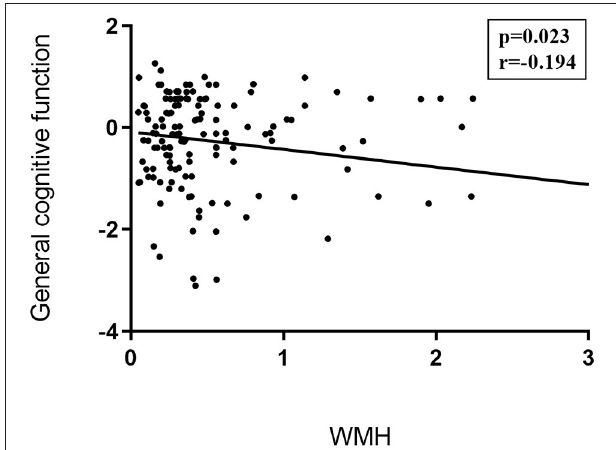
FIGURE 3 | Correlations between traditional CSVD image markers and neuropsychological examinations. Partial correlation was conducted controlling for age, gender, years of education, history of hypertension, and history of LI/TIA in patients with CSVD. General cognitive function was negatively associated with WMH ( r = − 0.194, p = 0.023). CSVD, cerebral small vessel disease; LI, lacunar infarction; TIA, transient ischemic attack;WMH, white matter